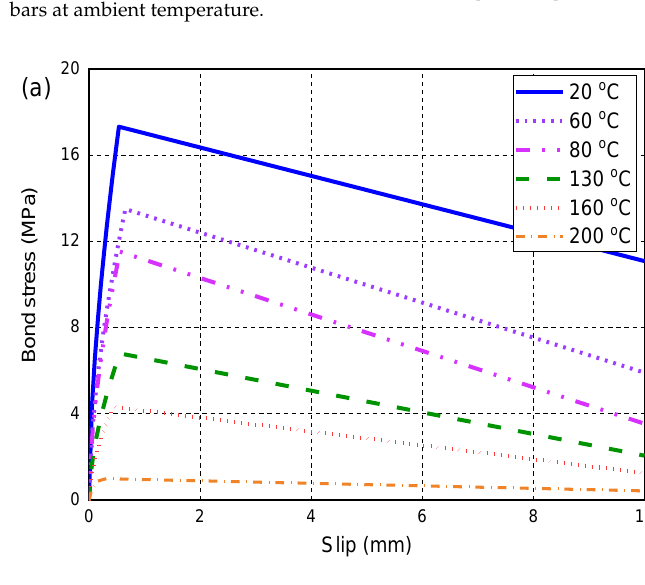
Figure 4. Cont (b)